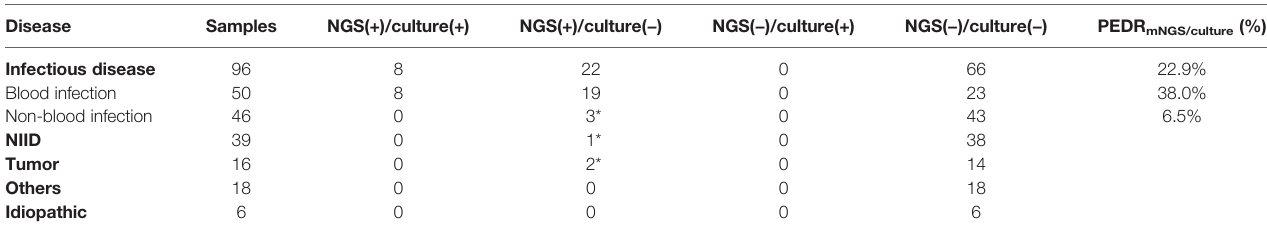
TABLE 3 | The diagnostic value of mNGS compared to culture in blood samples in FUO.